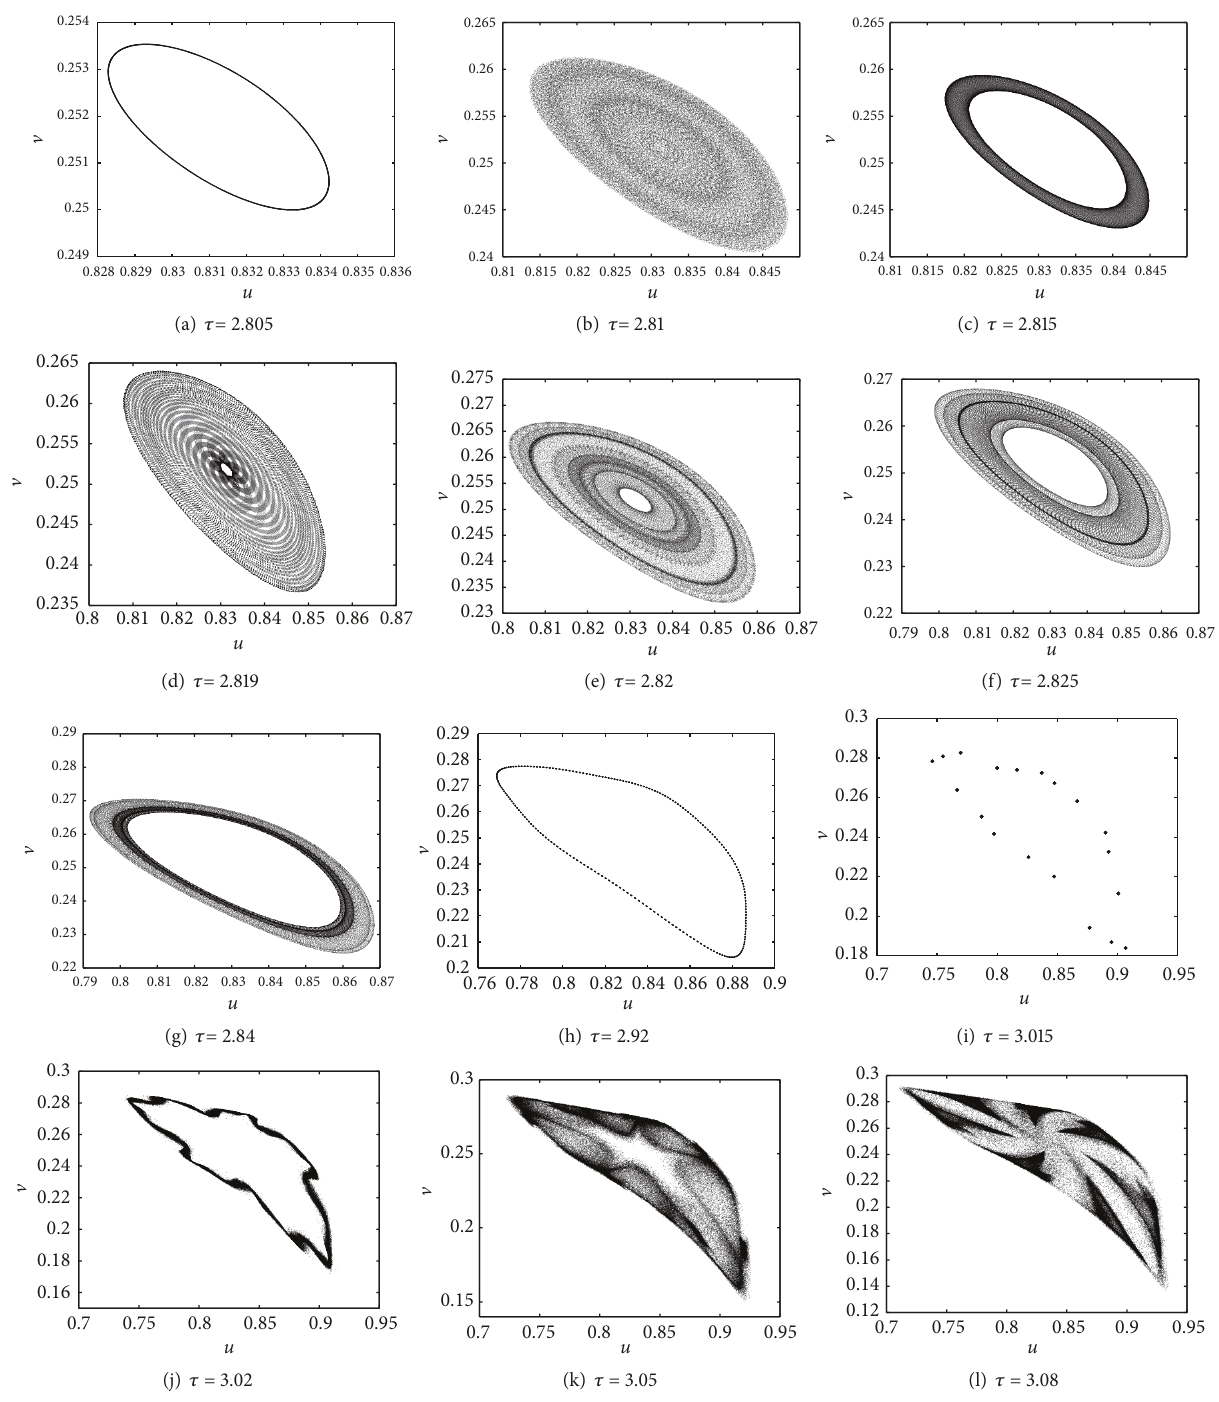
Figure 12: Phase diagrams for different values of parameter 𝜏 corresponding to Figure 11(a), demonstrating the predator-prey dynamics at one node of the coupled